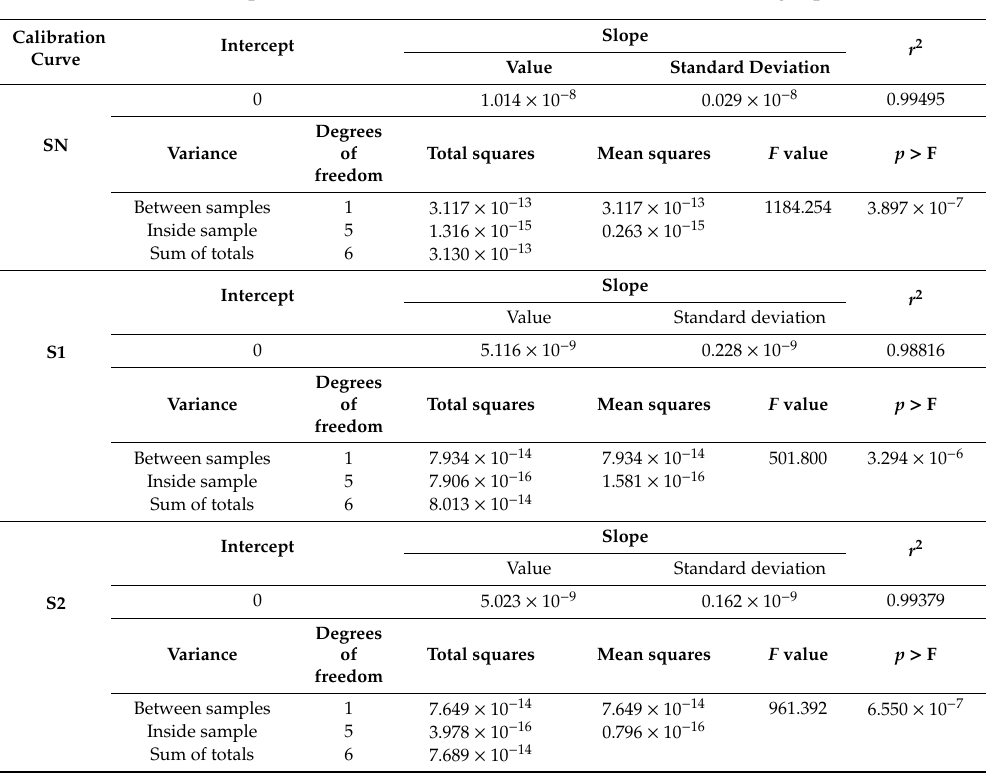
Table 1. Statistical parameters of three calibration curves based on naringin peak